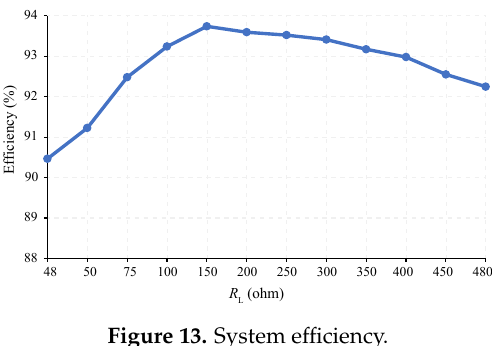
Figure 13. System efficiency. Table 2. Comparison of the publications for light-load efficiency